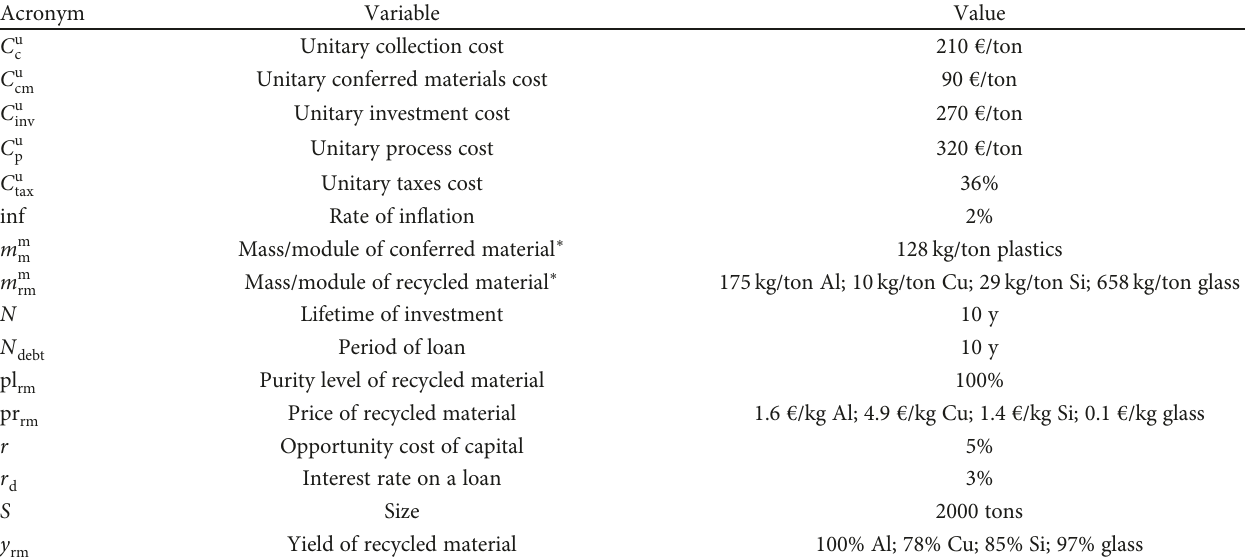
Table 1: Input values [20, 22].